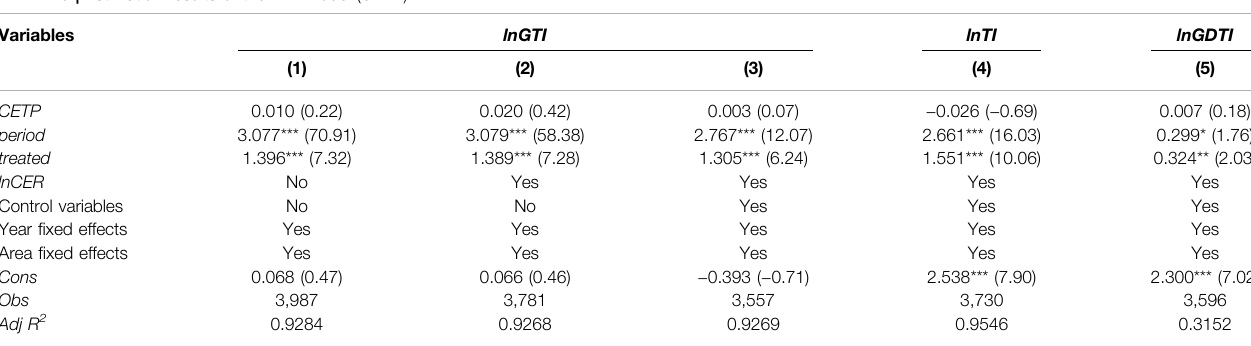
TABLE 3 | Estimation results of the DID model ( CETP )